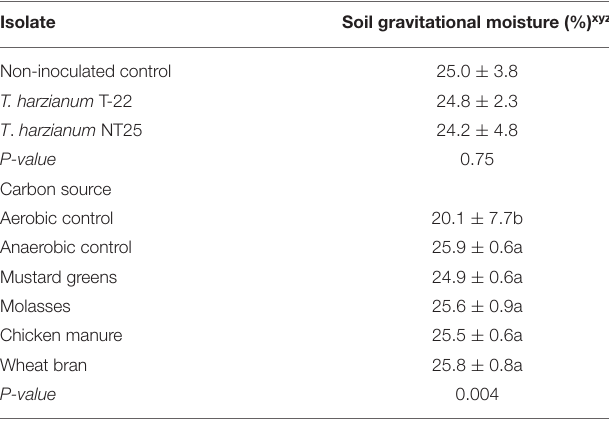
TABLE 2 | Gravitational moisture percentage of soil after anaerobic soil disinfestation (ASD) with different carbon source amendments and with or without Trichoderma spp.